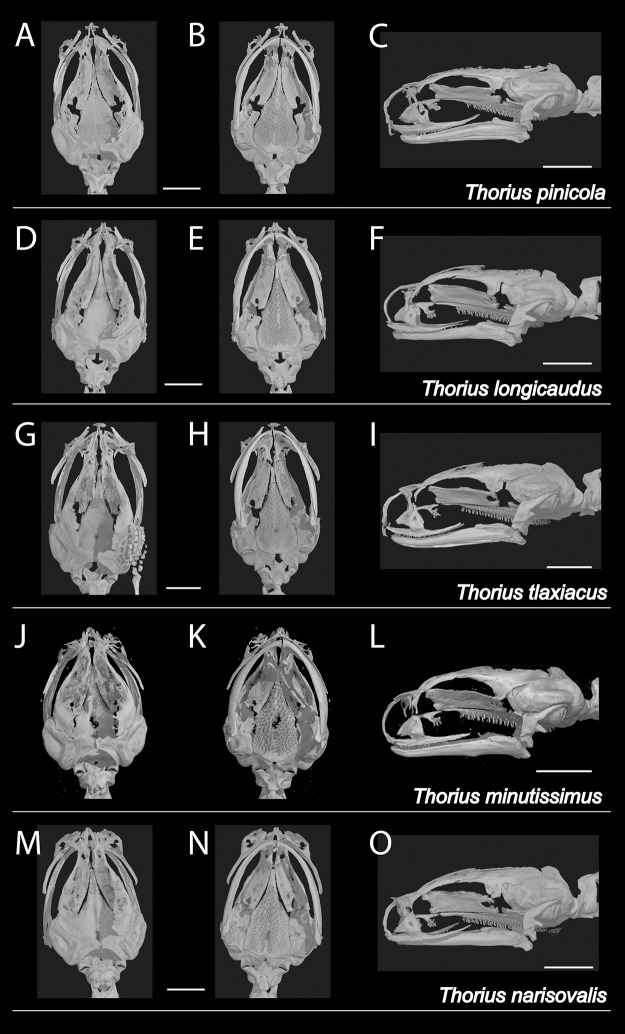
X-ray micro-computed tomography (µCT) scans of adult skulls.(A–C) Thorius pinicola, MCZ A-136429, paratype, male; (D–F) T. longicaudus, MCZ A-137819, holotype, female; (G–I) T. tlaxiacus, MVZ 183447, paratype, male; (J–L) T. minutissimus, IBH 23011, female; and (M–O) T. narisovalis, MVZ 162257, female. Each skull is shown in dorsal (left), ventral (middle) and left lateral views. The skeleton of the right hand is visible in G. Total length of each skull is only 3–4 mm; scale bar, 1 mm.